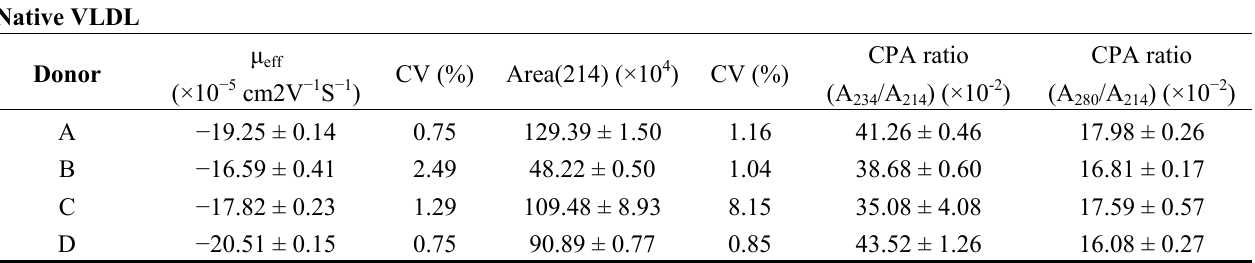
Table 1. The average effective mobility, peak area and peak area ratios of native VLDL particles analyzed by CZE (data are means ± SD of four